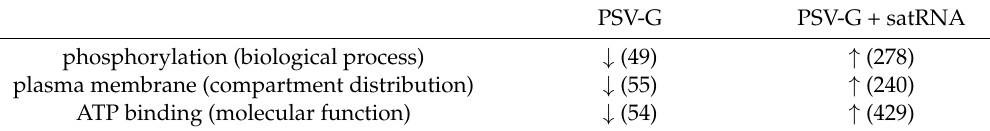
Table 2. Contrasting effects ( ↑ —increase and ↓ —decrease) of the absence or presence of satellite RNA Figure 7. Gene ontology terms for DEGs of Nicotiana benthamiana infected with PSV-G ( A ) and PSV + (satRNA) in PSV-G infected Nicotiana benthamiana plants. The distribution of GO terms assigned to the satRNA ( B ). The z-score was assigned to the x-axis and the negative logarithm of the adjusted p - differentially expressed genes under the three GO functional categories is shown. value to the y-axis (the higher the more significant). The area of the displayed circles is proportional to the number of genes assigned to the term and the color corresponds to the three categories: Opposite Effects of PSV Infection in the Absence of Presence of satRNA (Number of Seqs) Biological Process (BP, red), Cellular Component (CC, green) and Molecular Function (MF, blue). The circles were labeled with the GO term name. On the right side a table connecting the IDs and terms is displayed. Only some of significant circles were labelled due to the limited space and the overlap of the circles. A threshold for the labeling was set based on the negative logarithm of the adjusted p -value (>1.3 which gives only GO terms that are significant at the 0.05 level).